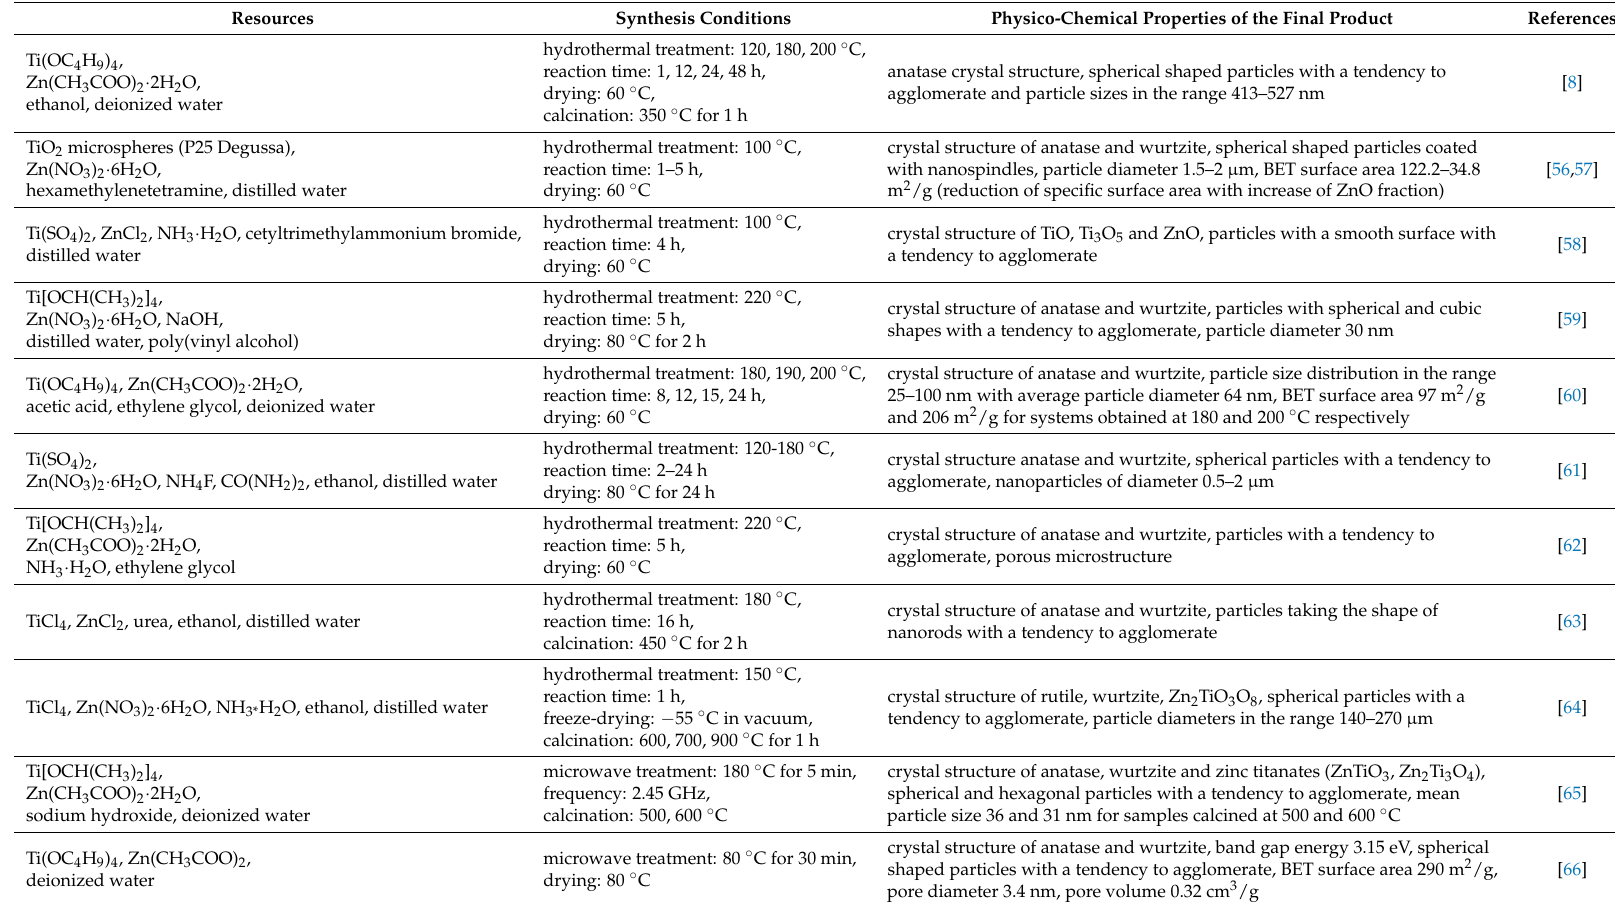
Table 1. Resources, synthesis conditions and physico-chemical properties of TiO 2 -ZnO oxide systems obtained by the hydrothermal